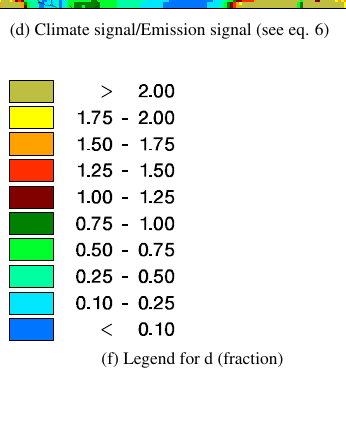
Changing the climate alone (Fig. 8a leads to a decrease in the nitrogen concentration in the future north of ∼ 50 ◦ N, ex- cept over Europe, where a small increase (0–10 %) is found over Great Britain, Denmark, southern Sweden and the North and Baltic seas (Fig. 8a). At subtropical and tropical lati- tudes, the impacts from climate change gives rise to an in- crease in the N concentration in the order 0–30 % (Fig.